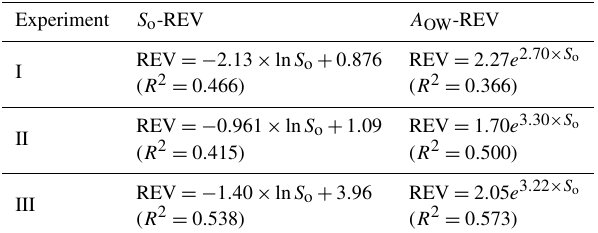
Table 4. The fitted relationship between REV and S o